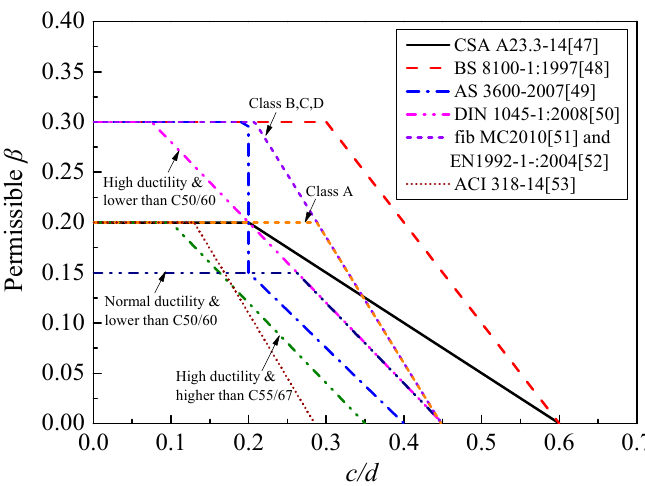
Figure 14. Comparison of various code provisions for moment redistribution.